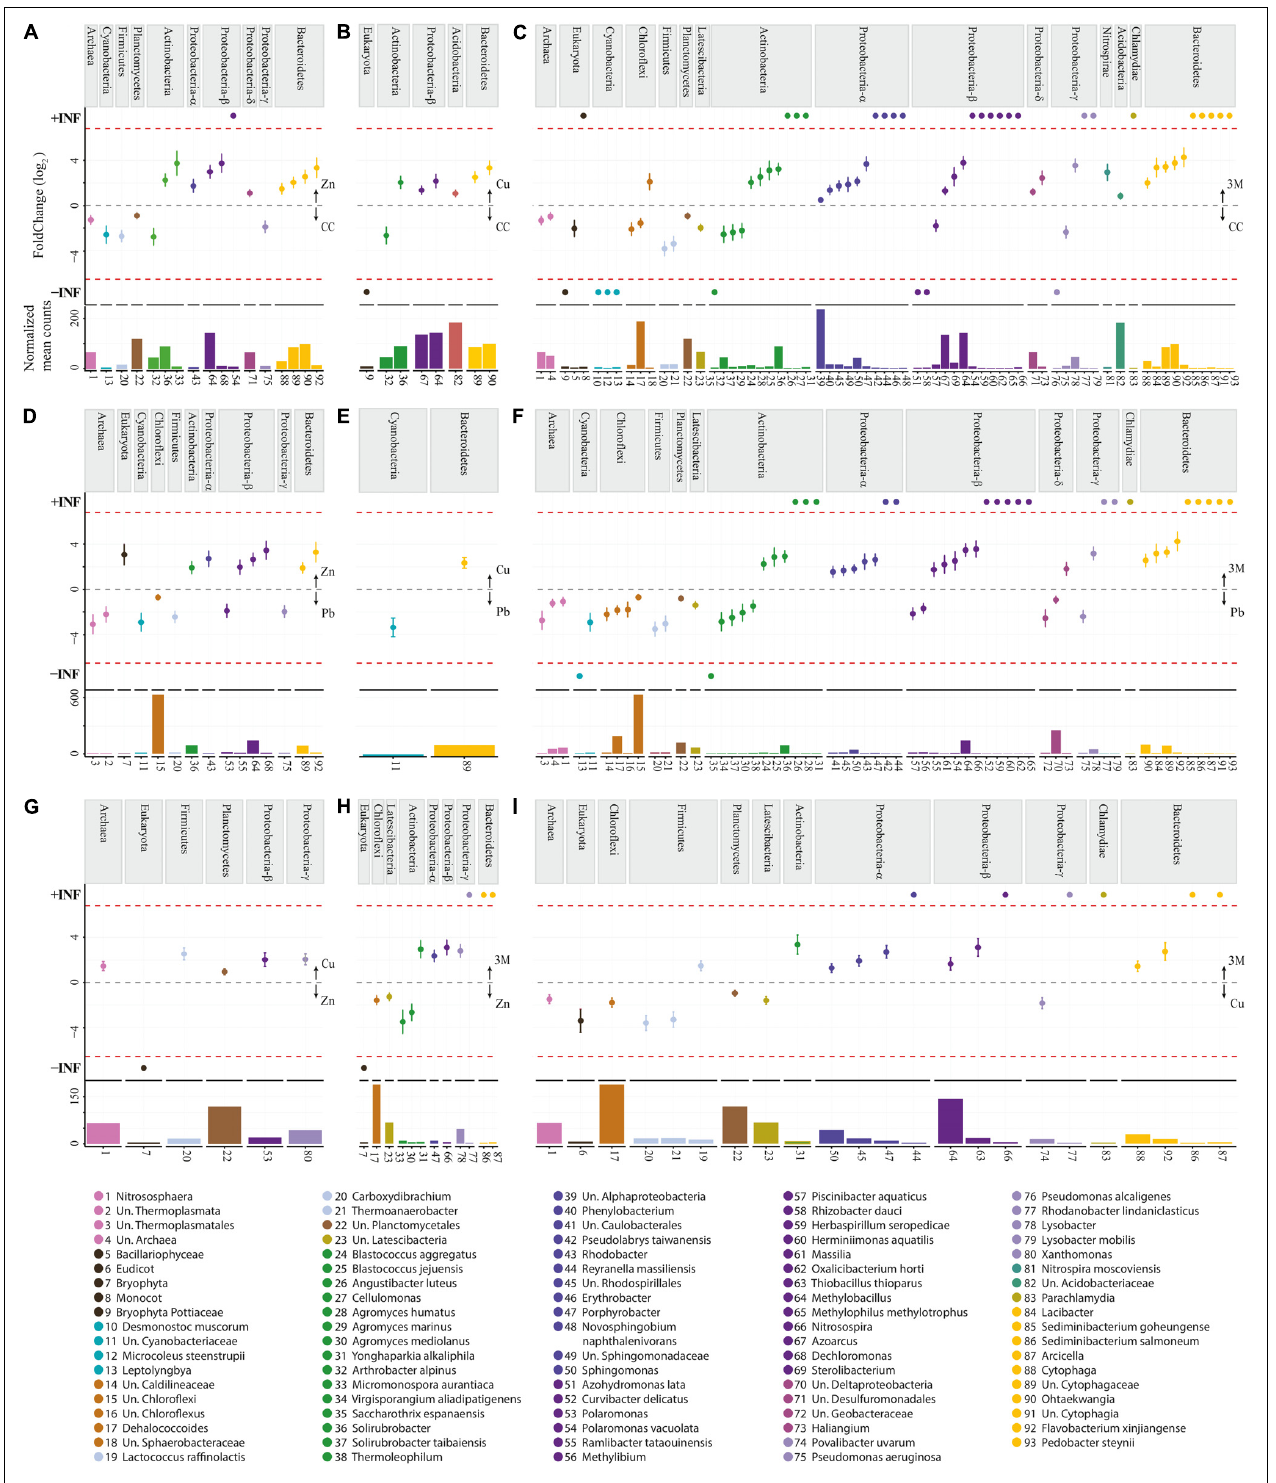
FIGURE 4 | Differentially expressed OTUs: abundance and fold change. (A) Control (CC) vs Zn; (B) CC vs Cu; (C) CC vs three metals (3M); (D) Pb vs Zn; (E) Pb vs Cu; (F) Pb vs 3M; (G) Zn vs Cu; (H) Zn vs 3M; (I) Cu vs 3M. No OTUs were identified as differentially abundant between CC and Pb treatments. Fold change (FC Log 2 ) denotes relative differences in abundance between treatments (directionality is indicated with arrows on the right of each graph). + / − INF indicates “infinite” fold change, where an OTU had counts in only a single condition. Normalized mean counts originate from DESeq2 basemean output (note: y -axis max is not constant). Species are grouped by phylum per comparison as well as using